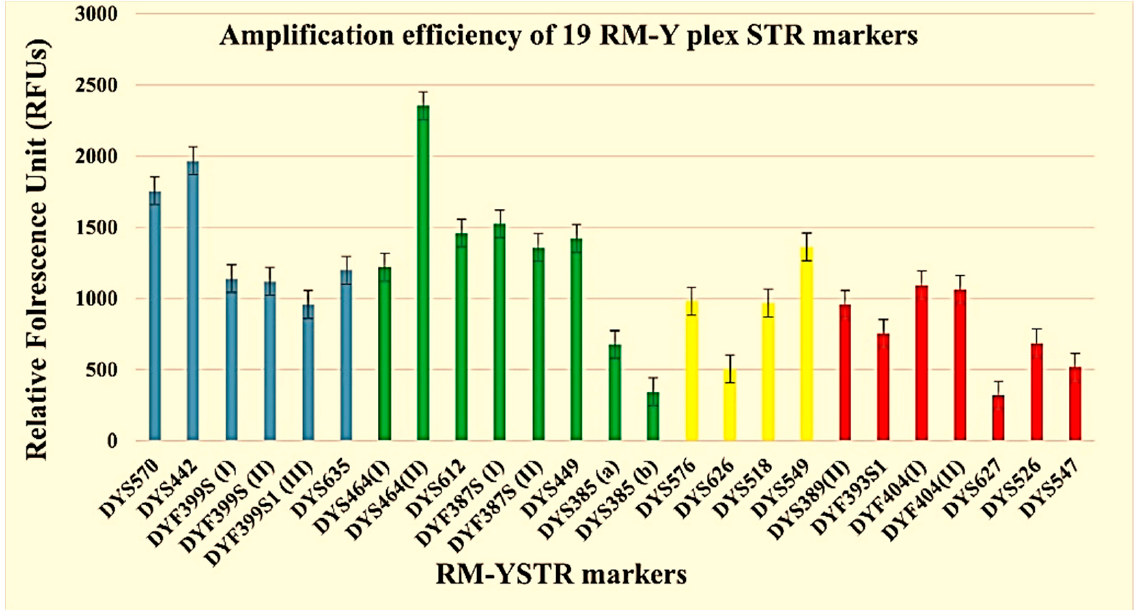
Figure 1. The peak height intensities of each amplified RM Y STR marker based on the 10 genotyping runs of the 9948 control DNA.